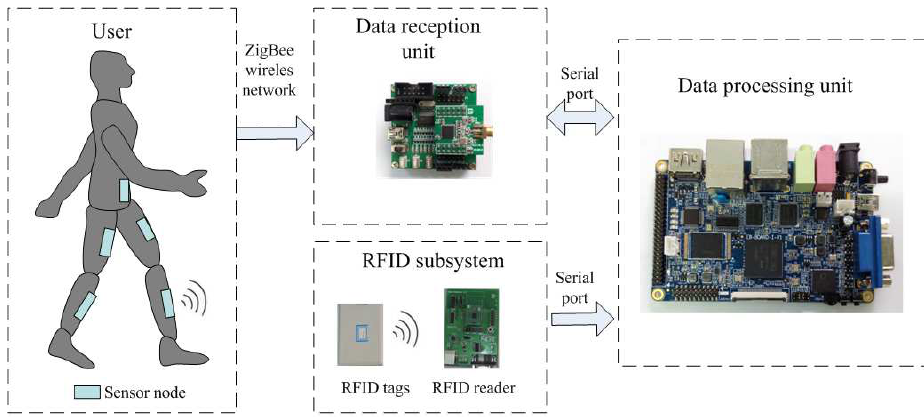
Figure 1. The structure of the integrated wireless wearable sensor system.